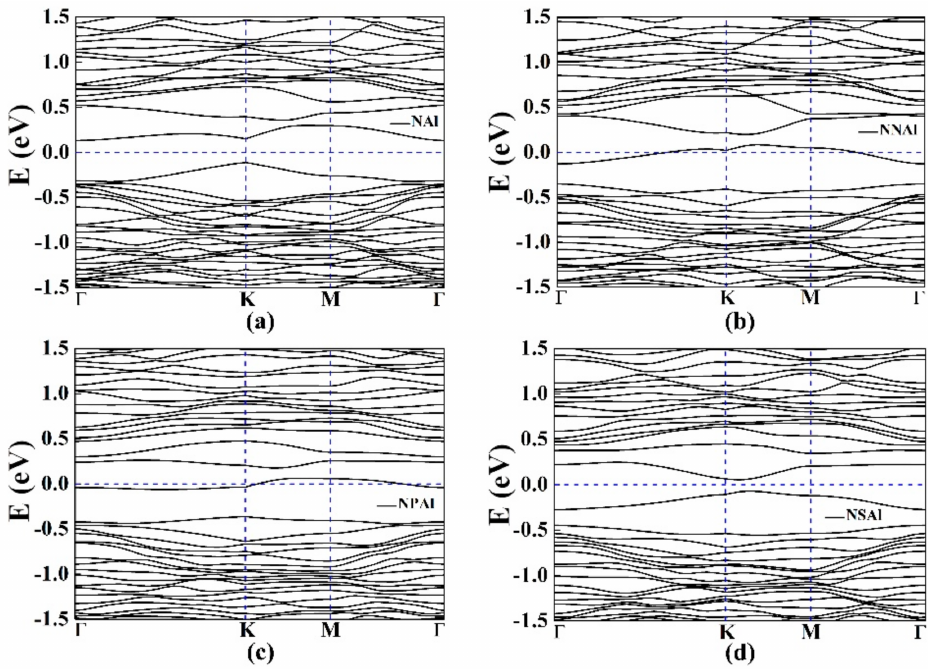
Figure 8. The band structures of single-vacancy germanene co-doped with the ( a ) NAl, ( b ) NNAl, ( c ) NPAl and ( d )